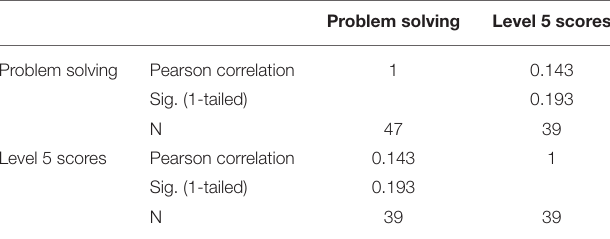
TABLE 5 | Correlation analysis for Level 5